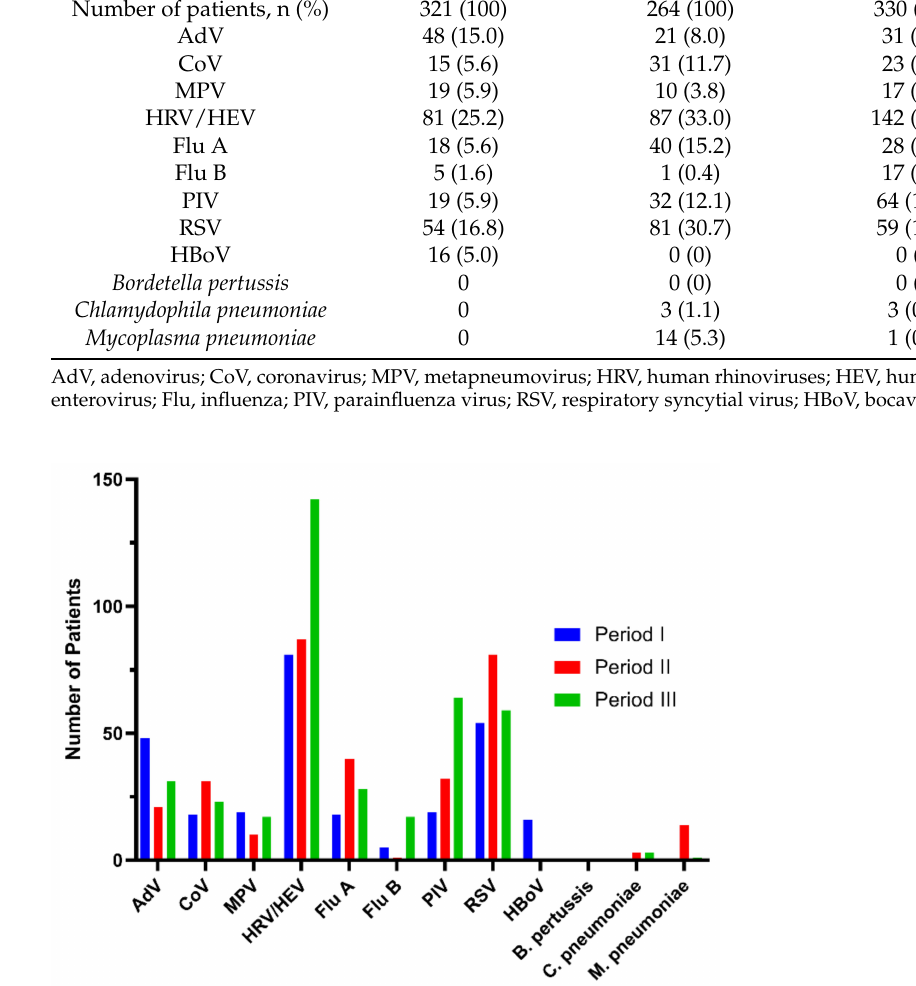
Figure 2. The results of positive respiratory virus tests according to